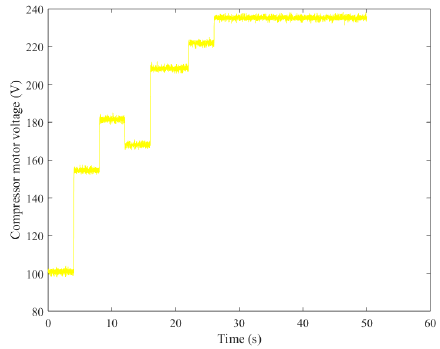
Figure 6. Compressor outlet pressure changes with time.